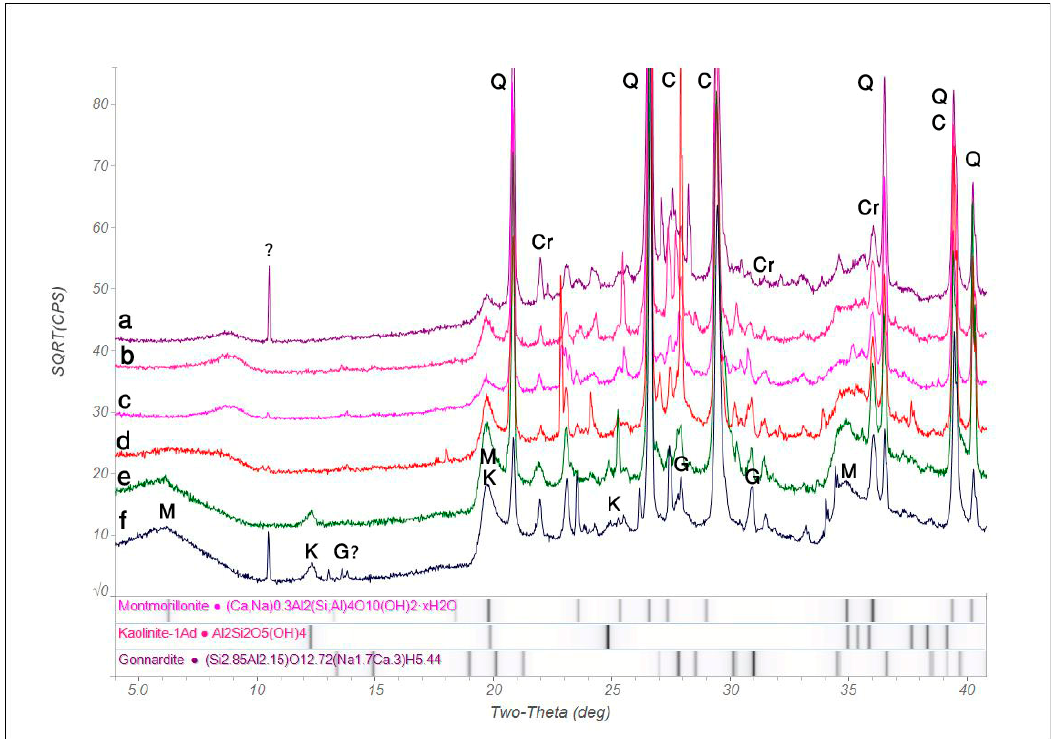
Figure 5. X-ray powder di ff raction spectra of the 6 samples: (a) 514-1, (b) 514-3, (c) 563, (d) 564, (e) 570 and (f) 569. The spectra are shown as recorded, and the peak intensities have not been normalized. Thus, the peak heights approximately reflect the relative proportions of the mineral components, assuming that this is a true powder with no preferred orientations. The strong reflections of the abundant quartz, cristobalite, and calcite minerals are identified on the top spectrum and the strong and non-overlapping reflections of kaolinite, montmorillonite, and gonnardite are identified on spectrum f. For comparison, we also show at the base of the image the reflections of kaolinite, montmorillonite and gonnardite obtained from a reference library (International Centre for Di ff raction Data (ICDD), PDF-4 + 2019). Q-quartz 98-000-0369; C-calcite 98-000-0141; M-montmorillonite 00-060-0318; Cr-cristobalite 98-000-0178; K-kaolinite 00-014-0164; G-gonnardite 98- 000-3619.